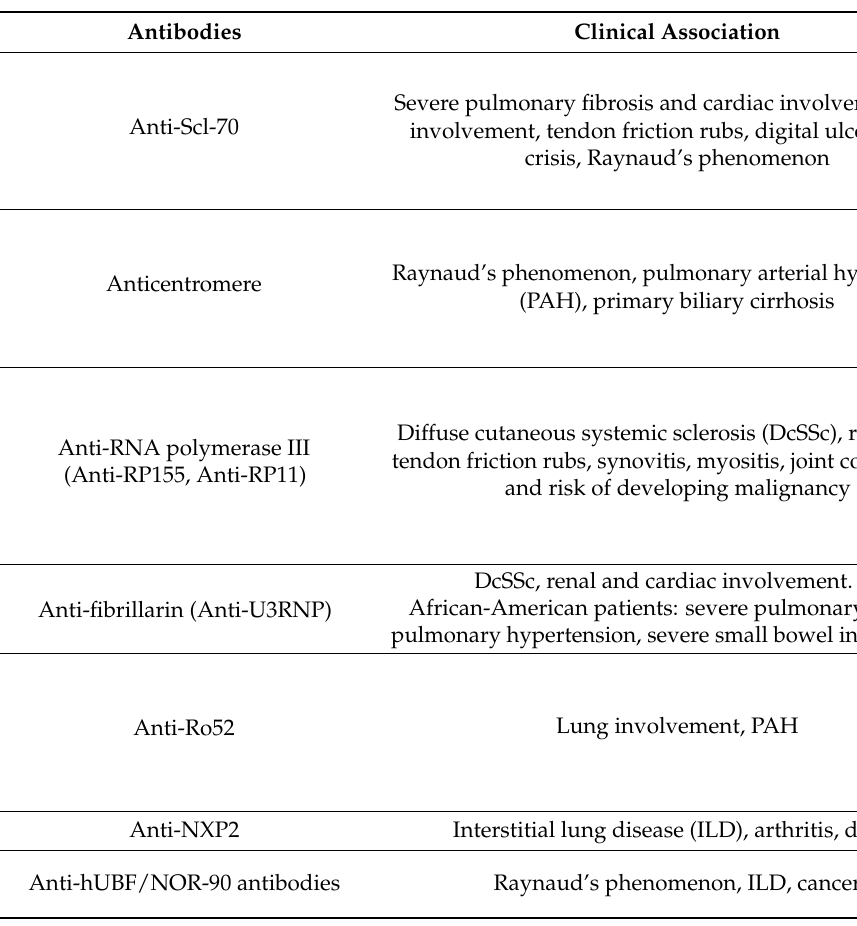
Table 3. Summary of the clinical associations, prevalence, and predictive value of autoantibodies in systemic